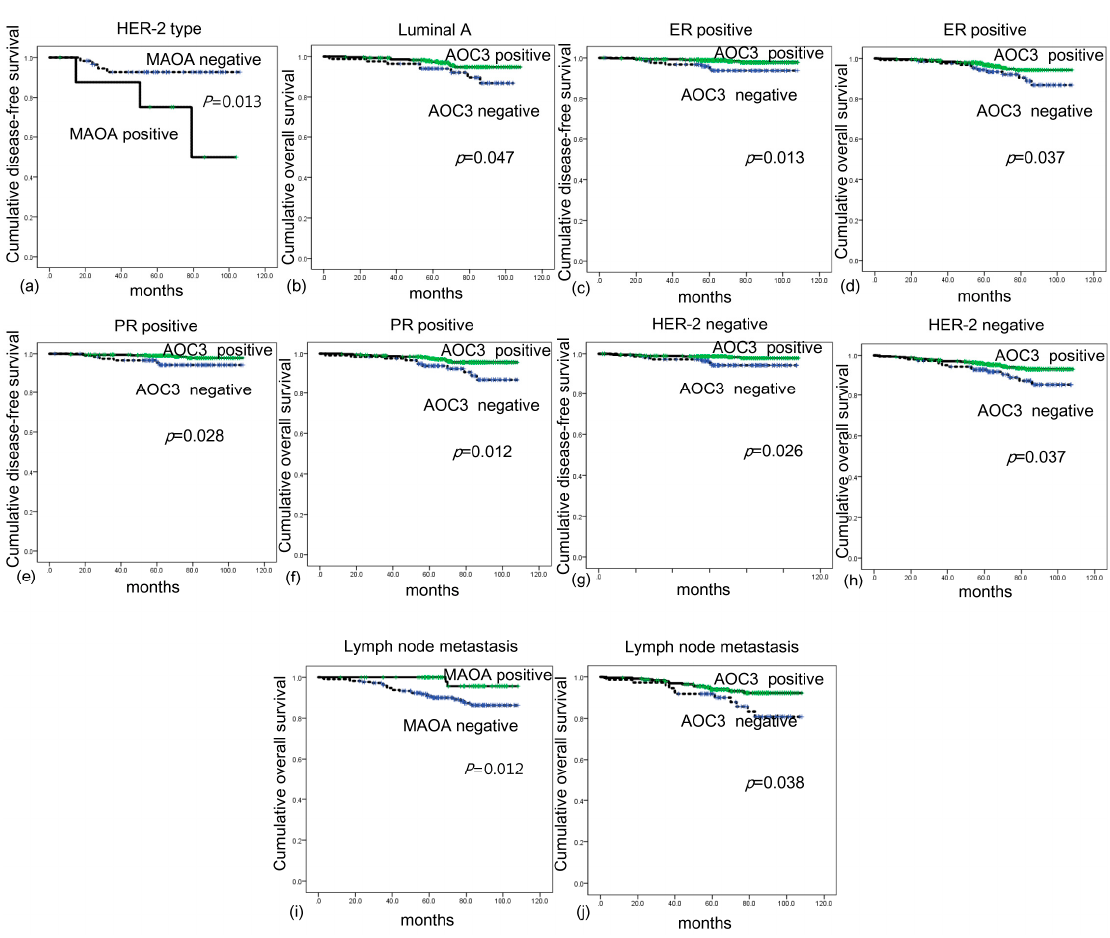
Figure 5. Effect of the expression of amine oxidase on survival in breast cancer. MAO-A positivity was associated with short DFS in HER-2-type breast cancer ( a ) ( p = 0.013), luminal A was associated with short OS ( b ) ( p = 0.047). In ER-positive breast cancer, AOC3 negativity was associated with short DFS ( c ) and short OS ( d ) ( p = 0.013 and p = 0.037, respectively). AOC3 negativity was associated with short DFS ( e ) and short OS ( f ) in PR-positive cancer ( p = 0.028 and p = 0.012, respectively). In HER-2-negative breast cancer, AOC3 negativity was associated with short DFS ( g ) and short OS ( h ) ( p = 0.026 and p = 0.037, respectively), and in the breast cancer showing lymph node metastasis, AOC3 negativity was associated with short DFS ( i ) and short OS ( j ) ( p = 0.038 and p = 0.012, respectively). Table 4. Univariate analysis of the impact of amine oxidase expression on breast cancer patient prognosis by log-rank